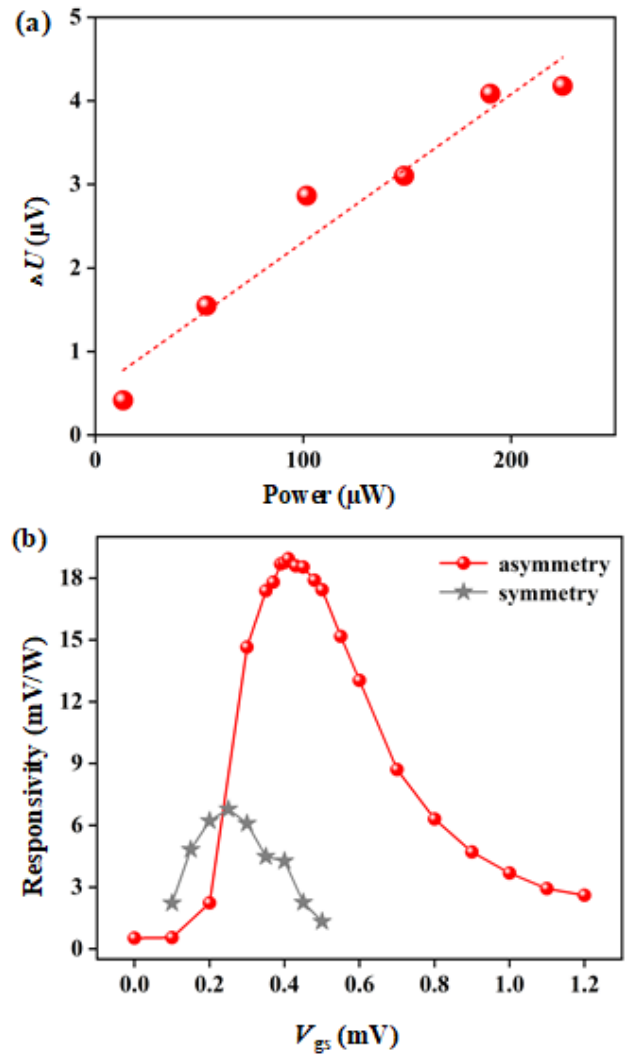
Figure 6. ( a ) The output voltage with different incident terahertz power under V gs = 0.43 V and V ds = 0 V conditions; ( b ) the asymmetry/symmetry detectors V gs -dependence responsivity at V ds = 0 V.